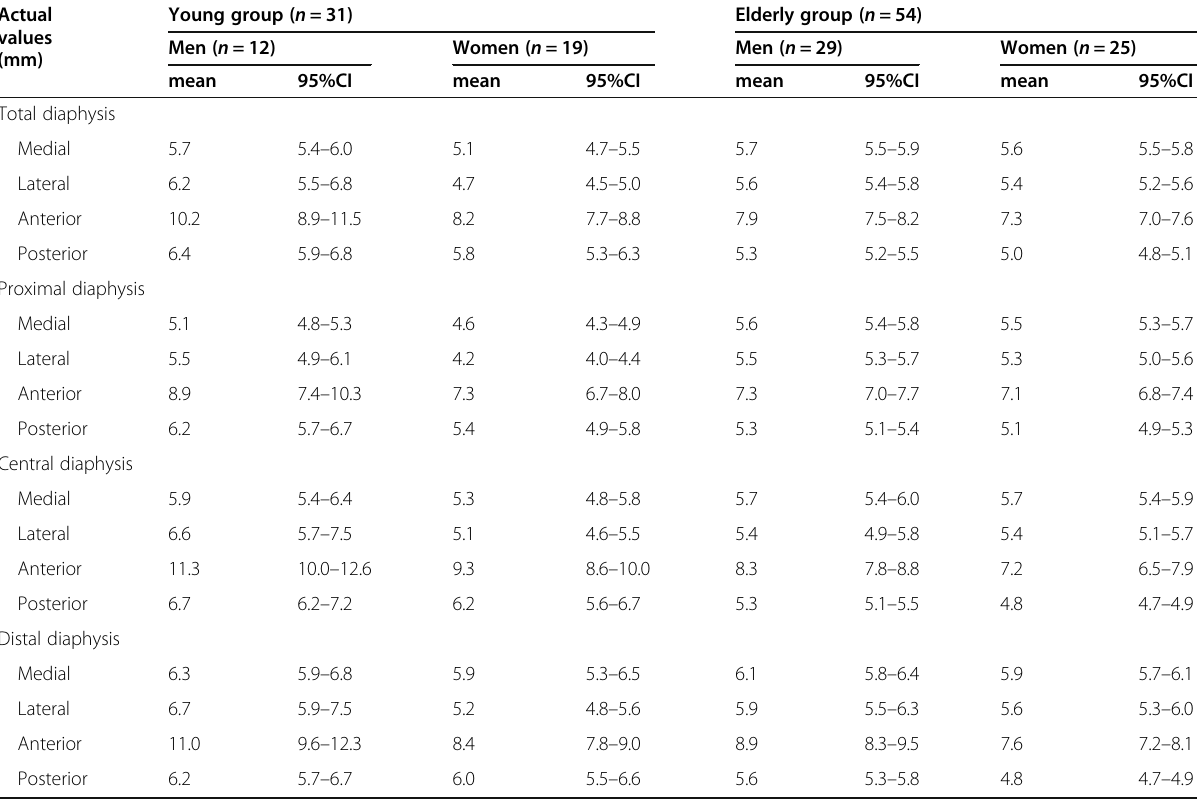
Table 1 Cortical thickness in the tibial diaphysis (actual